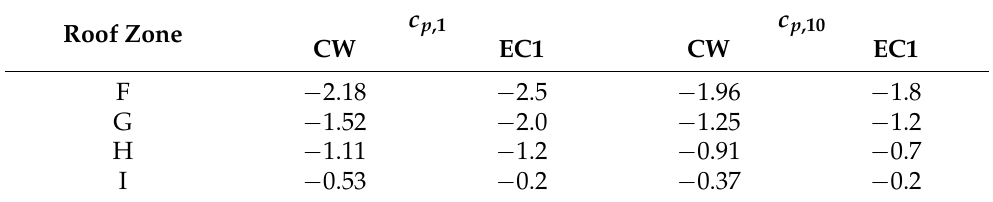
Figure 4. Pressure coefficients c p ,10 ( τ = 0.76s) for wind angles θ = 0 ◦ ( a ), θ = 15 ◦ ( b ), θ = 30 ◦ ( c ), and θ = 45 ◦ ( d ). Envelope of c p ,10 for θ = 0 ◦ , ± 15 ◦ , ± 30 ◦ , ± 45 ◦ , and Eurocode 1 loading zones ( e ). Table 1. Comparison of area-averaged coefficients from the analysis of NIST data (Current Work, CW ) and Eurocode 1 values ( EC1